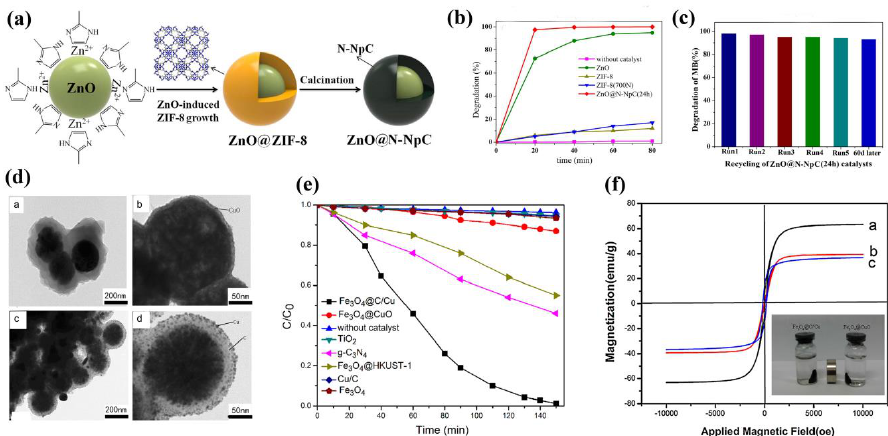
Figure 4. ( a ) Schematic illustration of ZnO@N-NpC formation. ( b ) Photodegradation cures of MB as a function of UV irradiation time in the presence of catalysts commercial ZnO, ZIF-8, ZIF-8(700N) and ZnO@N-NpC(24 h). ( c ) The MB photocatalysis repeatability test. Reproduced with permission from Reference [77]. Copyright 2017 Elsevier Inc. ( d ) TEM images of (a) Fe 3 O 4 @HKUST-1